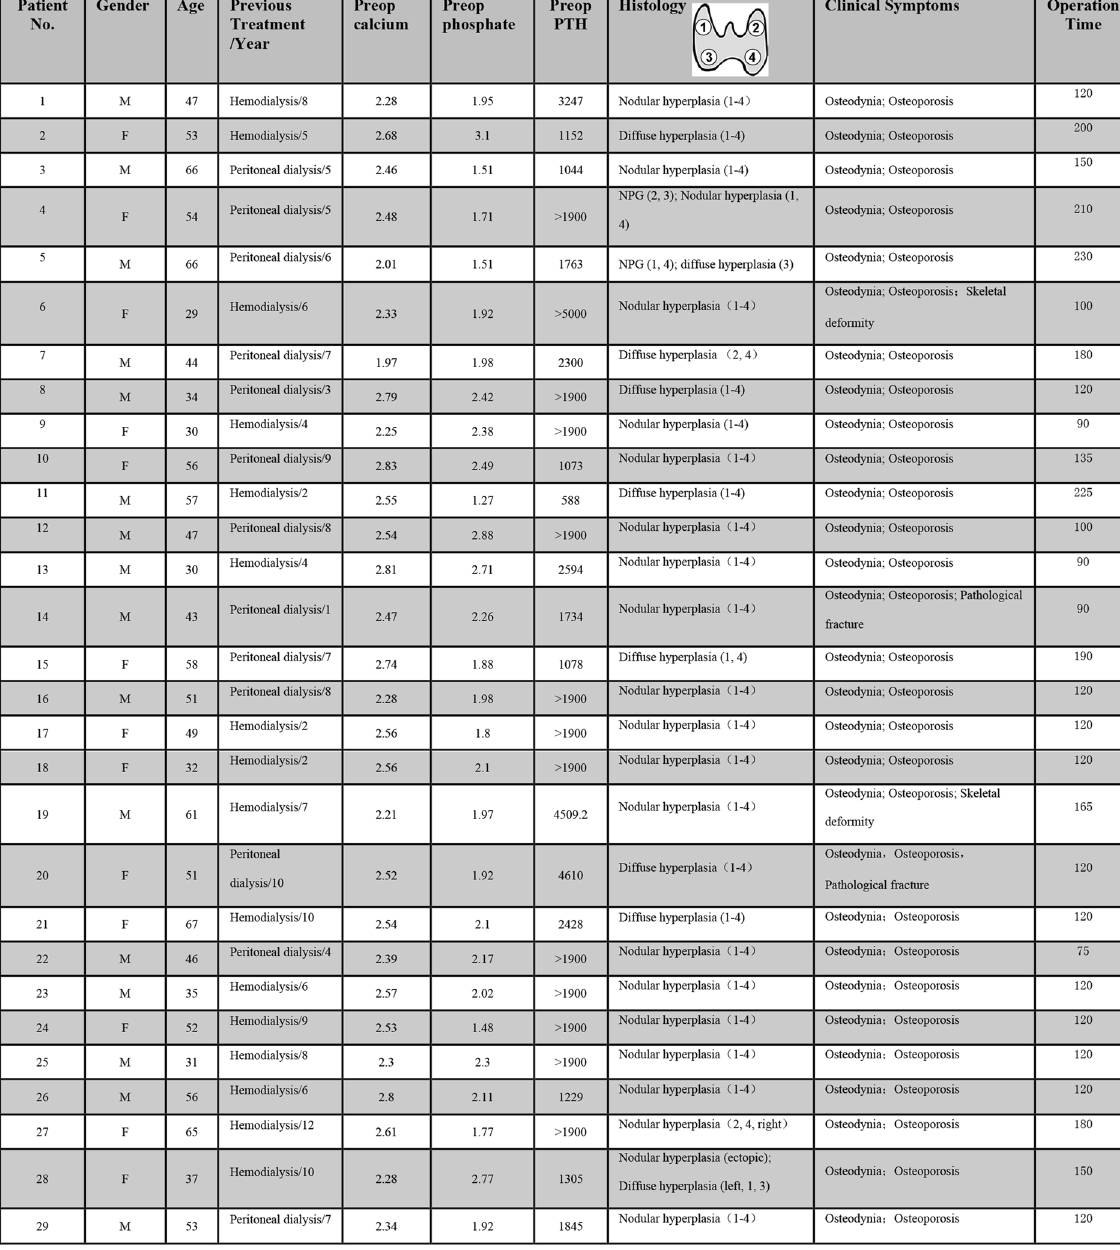
Figure 1. Patient, histopathologic and surgical characteristics. Abbreviations: M, Male; F, Female; Preop, preoperative; PTH, Parathyroid hormone; NPG, Normal parathyroid